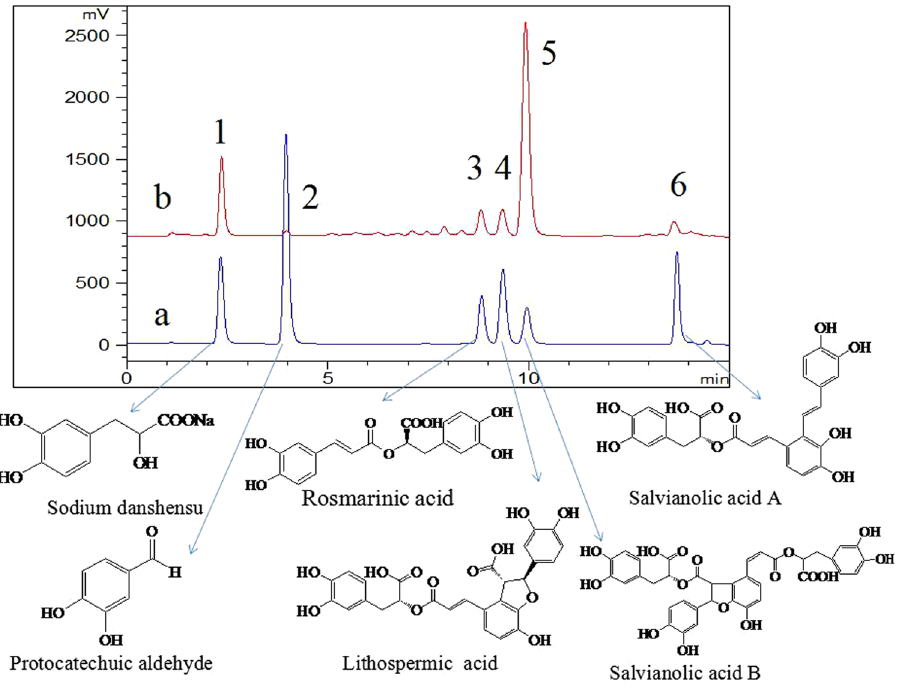
Figure 6. UHPLC-ECD chromatograms of six phenolic acids in standard mixture solution (25 μ g/mL)